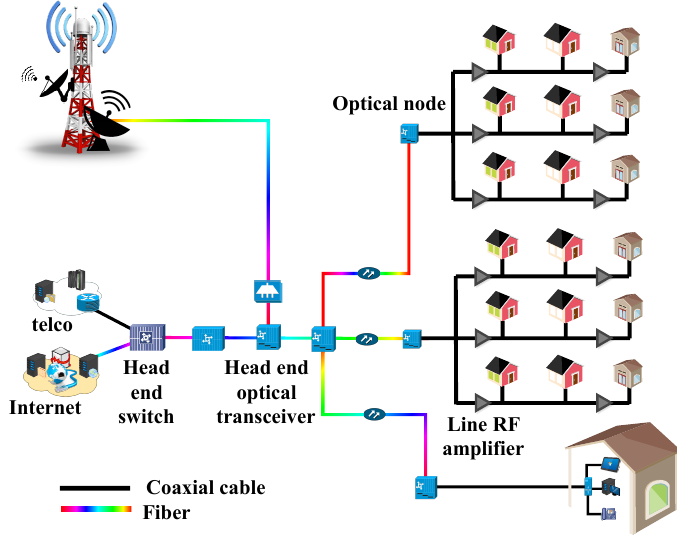
Figure 2. A typical HFC